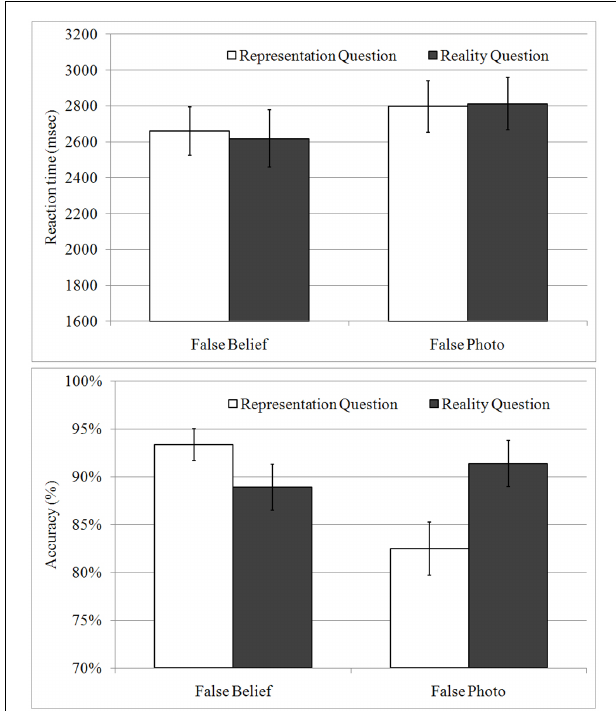
FIGURE 1 | Response time and accuracy for the comprehension questions. Bars represent the SE of the mean.